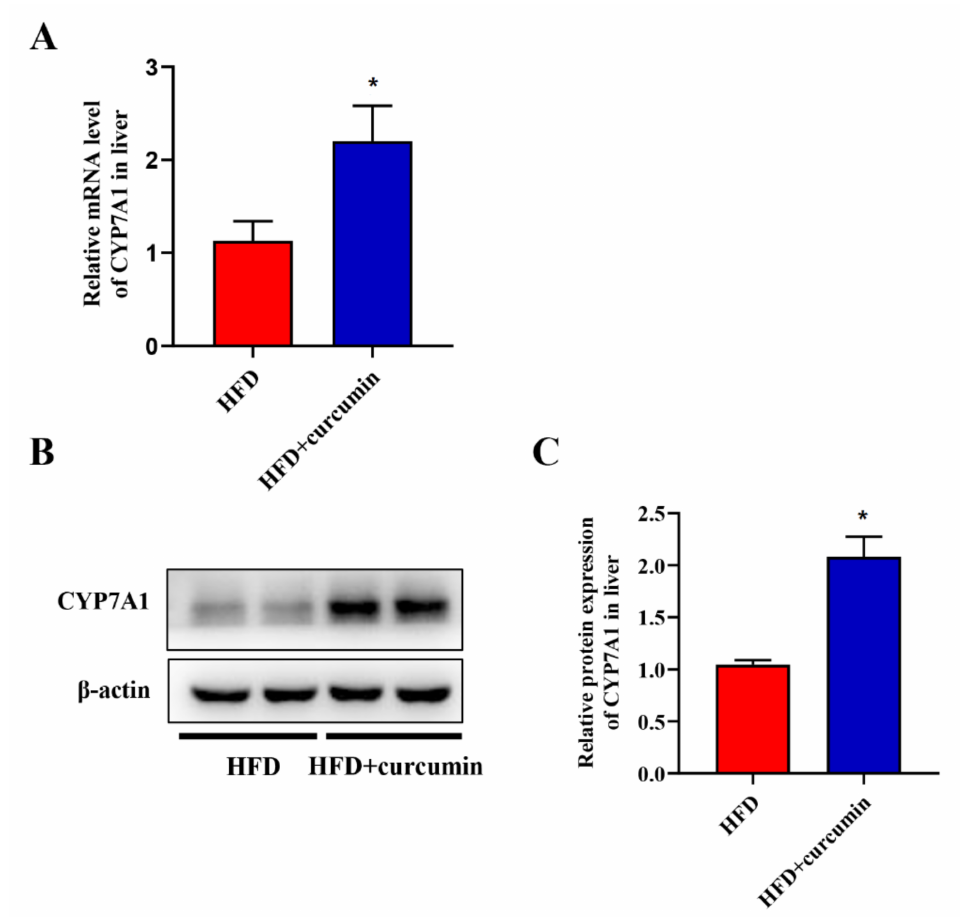
Figure 6. Effects of curcumin on liver CYP7A1 expression in HFD-fed hamsters. ( A ) The mRNA expression of CYP7A1 by RT-qPCR assay; ( B ) The protein expression of CYP7A1 by Western blotting assay; ( C ) Grey-scale quantitative analysis of Western blotting. Data are expressed as mean ± SEM ( n = 8), * p < 0.05 compared to HFD group. CYP7A1, Cytochrome P450 family 7 subfamily A member